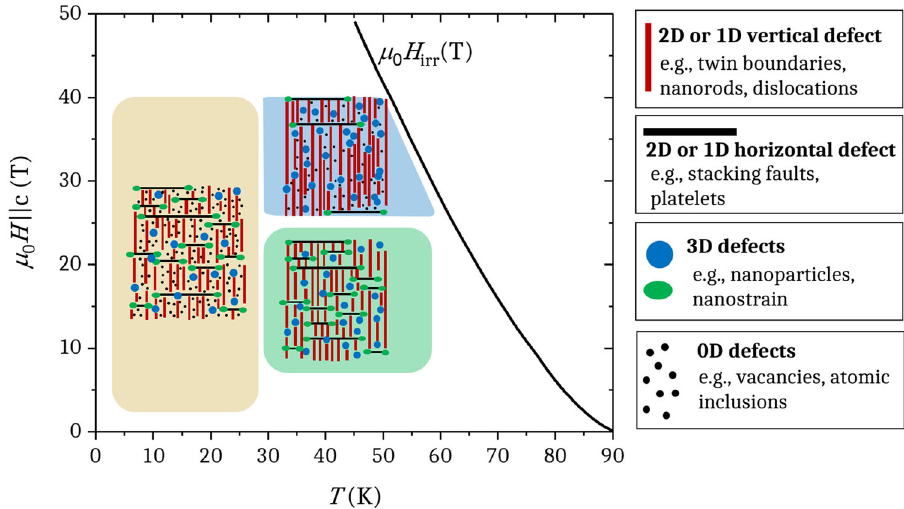
Fig. 8 Optimized pinning landscapes for H | | c. H – T diagram with three optimized pinning landscapes in the regions of: low temperatures from low magnetic fi elds to ~35 T, intermediate temperatures and intermediate magnetic fi elds (~15 T) and intermediate temperatures and very high magnetic fi elds (~35